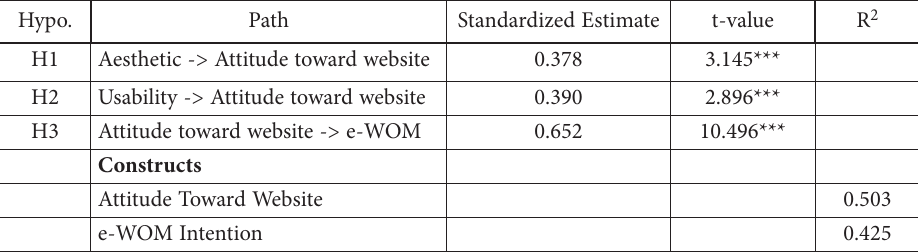
Table 5. Evaluation of structural model and hypotheses